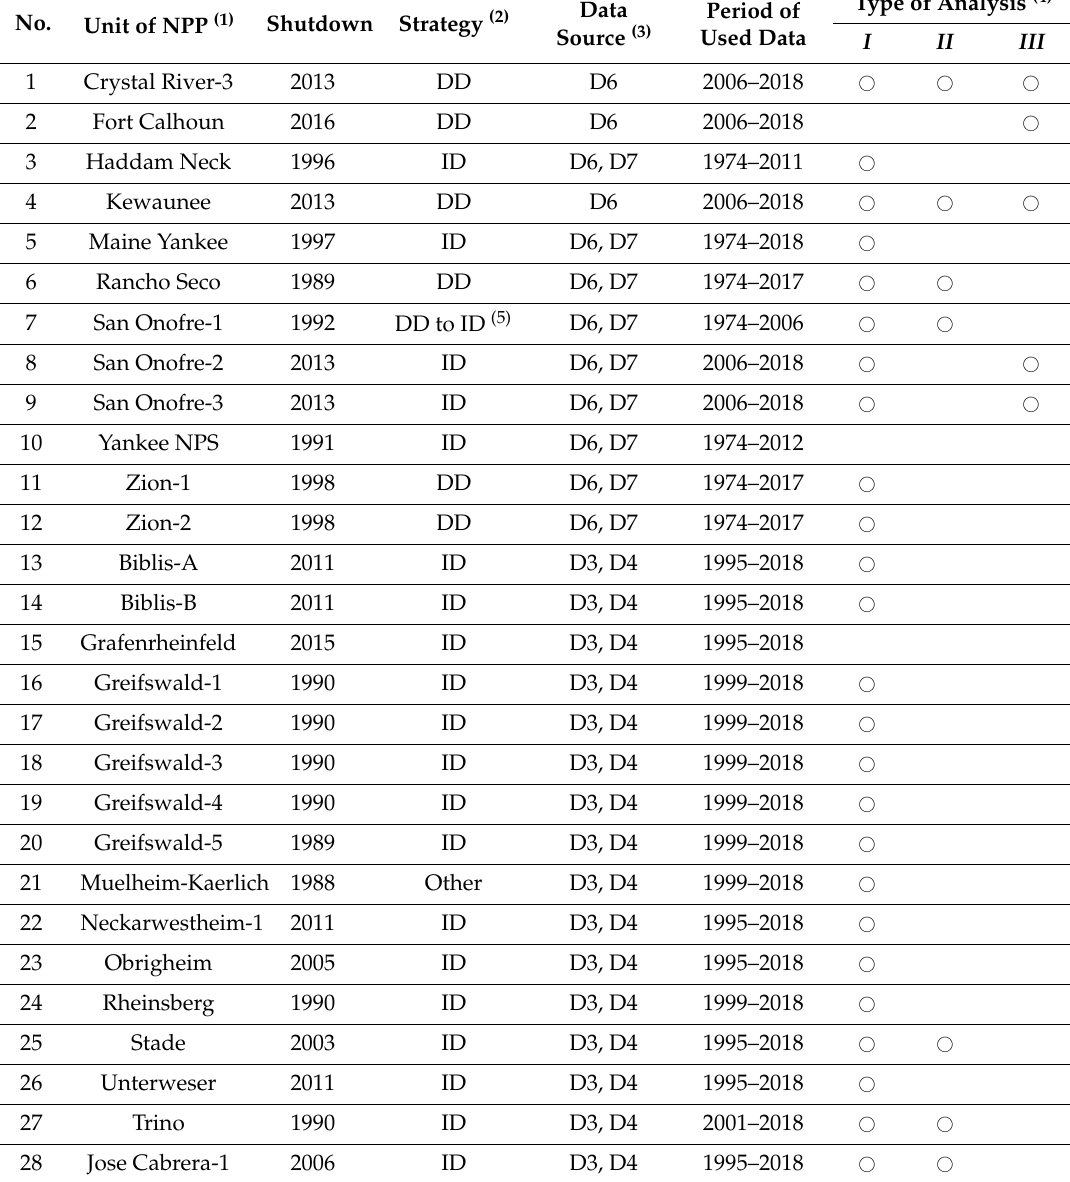
Table 2. Permanently shut down PWRs around the world of which radioactive e ffl uent data have been utilized in this study and types of analysis